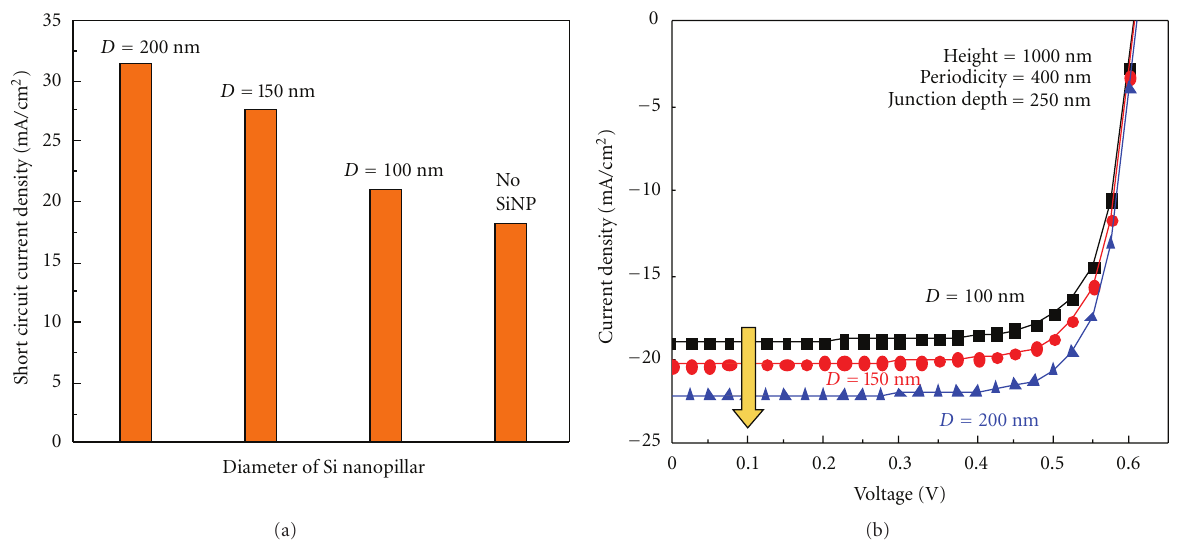
Figure 22: (a) Measured J sc as a function of Si nanopillar diameter under AM 1.5 G 100 mWcm − 2 illumination (b) Simulated J-V characteristic of Si nanopillar thin film solar cell (with underlying Si thin film of ∼ 800 nm). (Reprinted with permission from [8]. [2010]